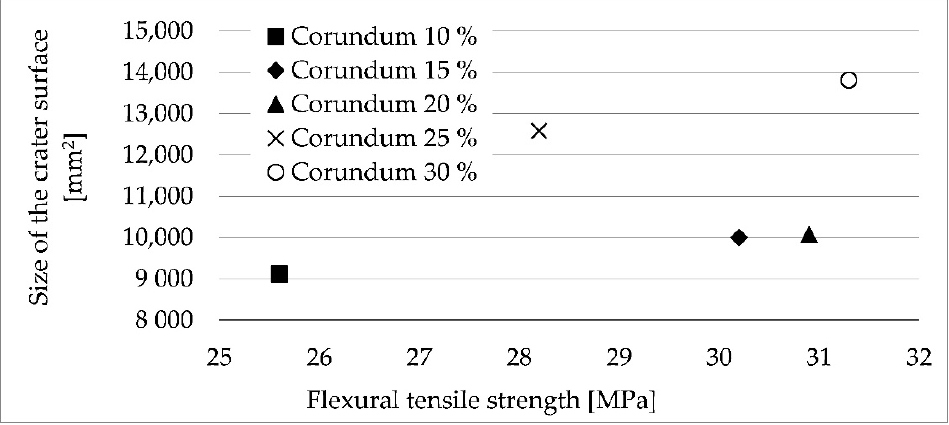
Figure 15. Rear side crater area versus flexural strength.